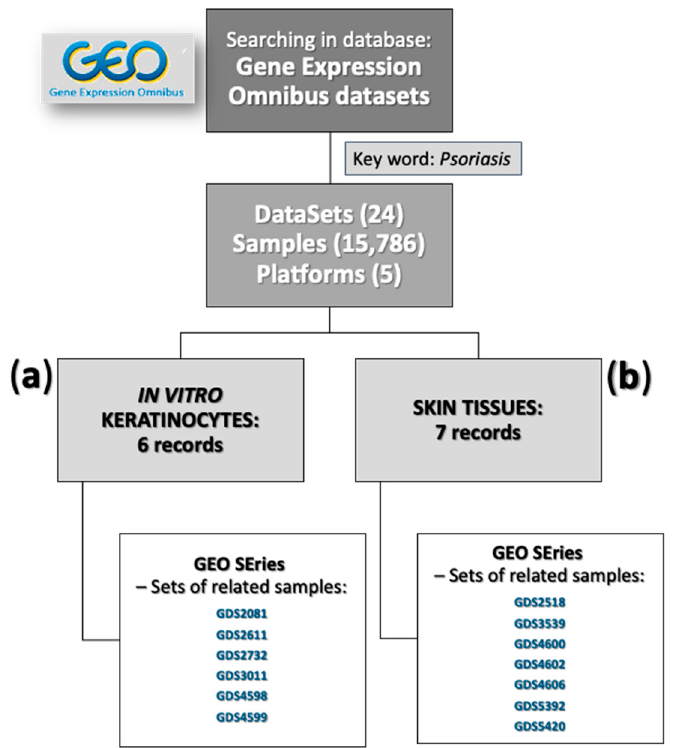
Figure 2. Study pipeline that represents the identification of registers referring to the Gene Expression Omnibus (GEO) profiles of psoriasis (Ps) in vitro cell culture of keratinocytes ( a ); and Ps lesional (PP) vs. non-lesional (PN), PP vs. normal ( b).